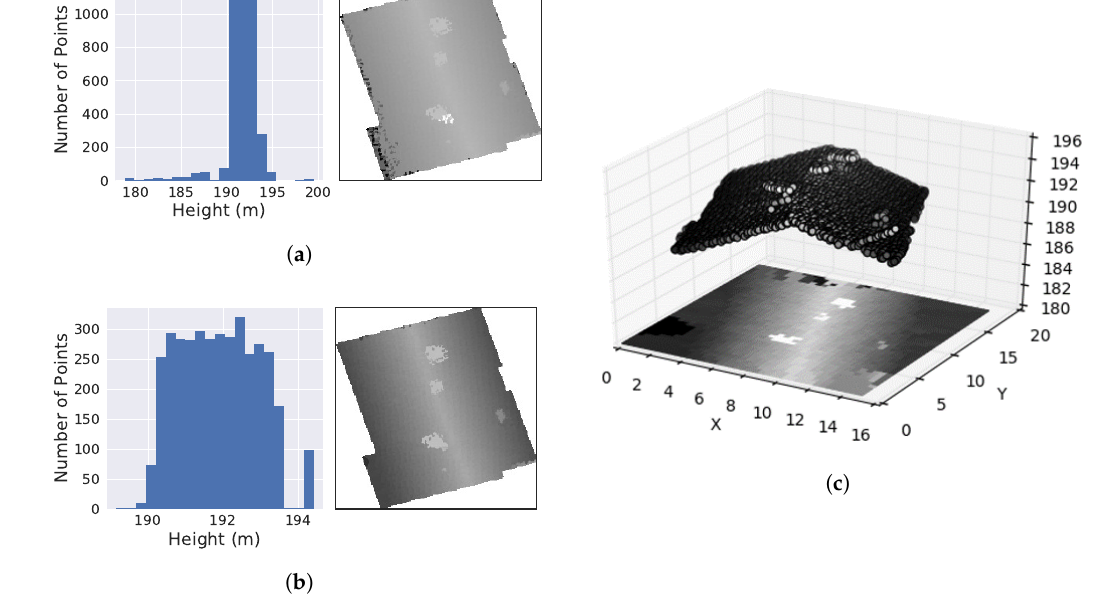
Figure 4. LiDAR data of a gabled roof. Histogram of height distribution and generated image ( a ) before filtering and ( b ) after filtering, using median absolute deviation. ( c ) Projection of filtered point cloud.